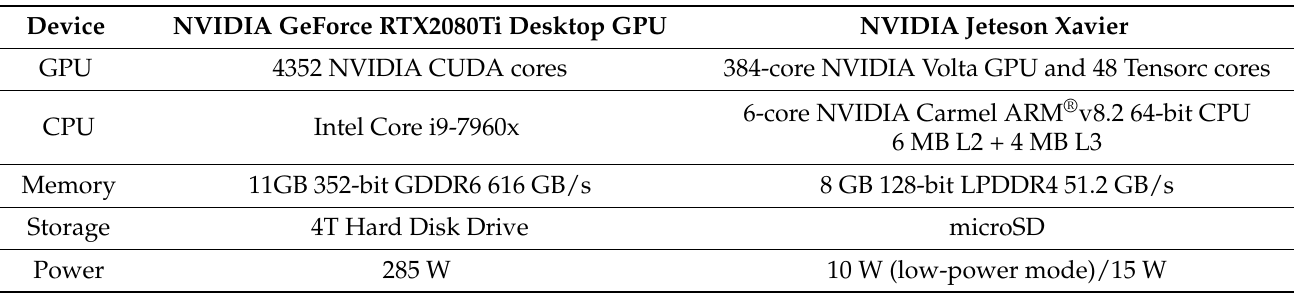
Table 2. Characteristics of two different hardware